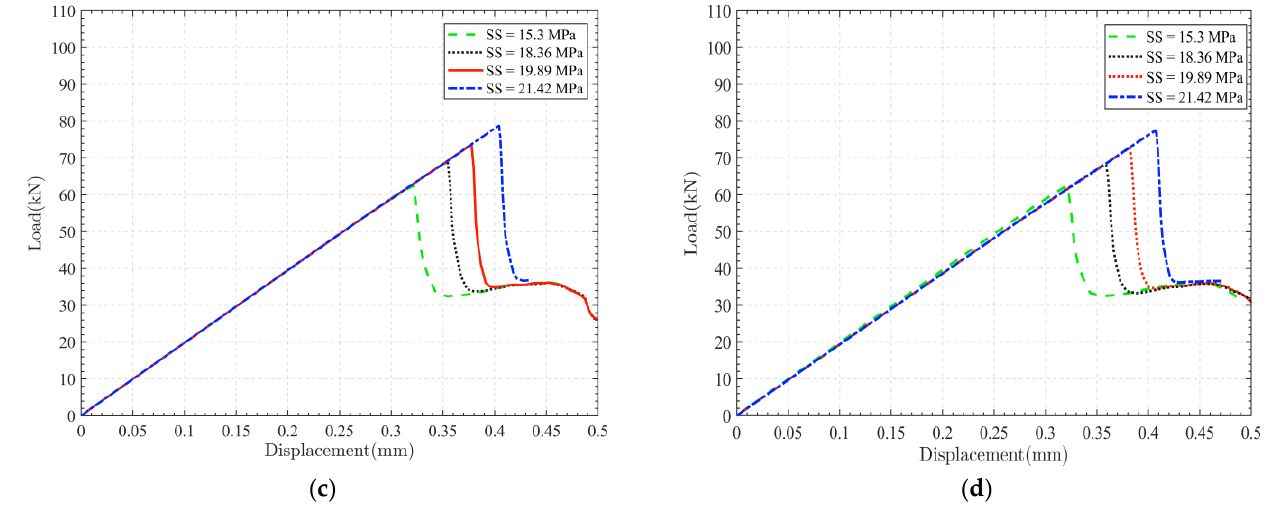
Figure 14. Load – displacement of different materials; ( a ) ys = 450 MPa; ( b ) ys = 800 MPa; ( c ) ys = 1200 MPa; ( d ) ys = 1300